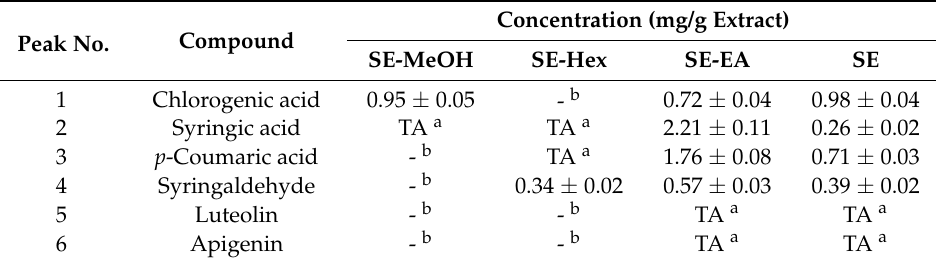
a TA: Trace amount; b -: Not